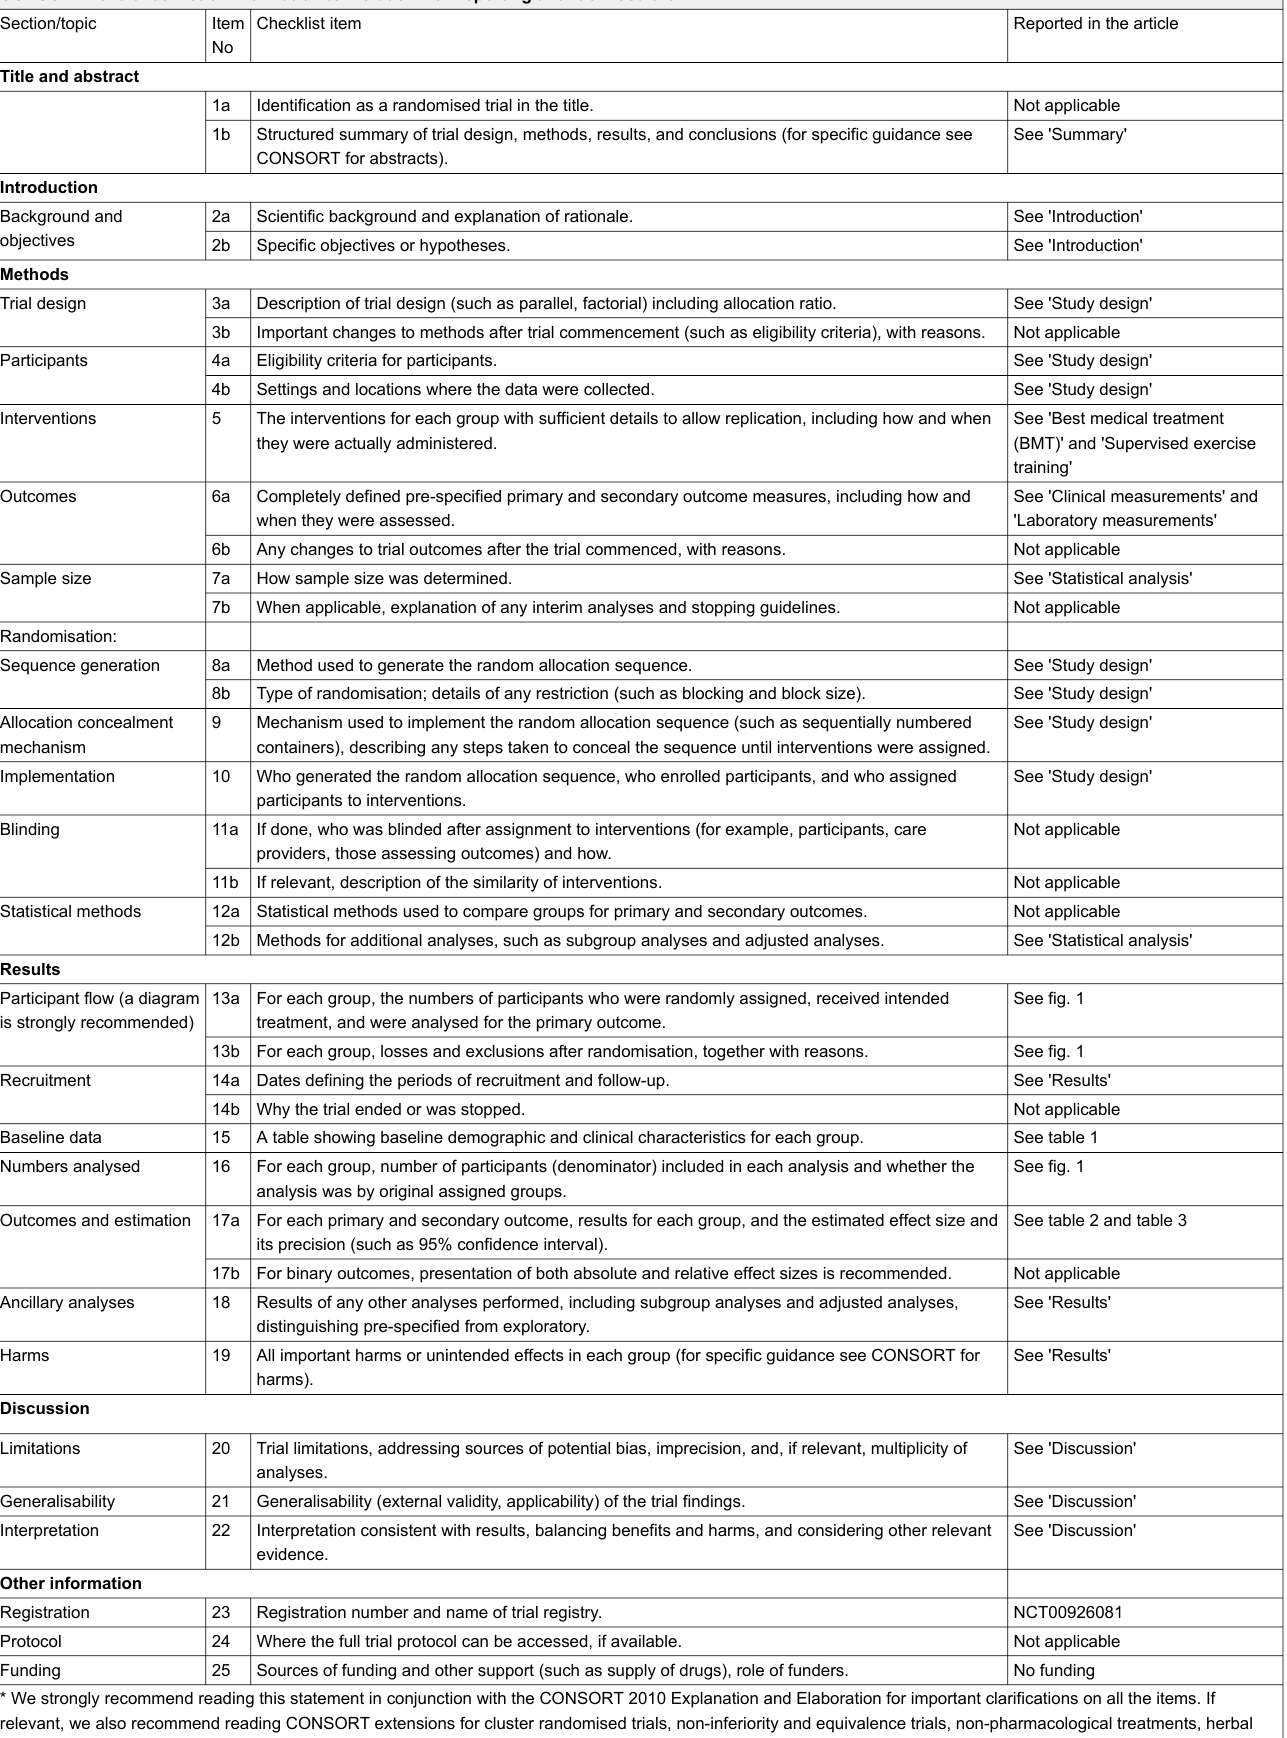
A table showing baseline demographic and clinical characteristics for each